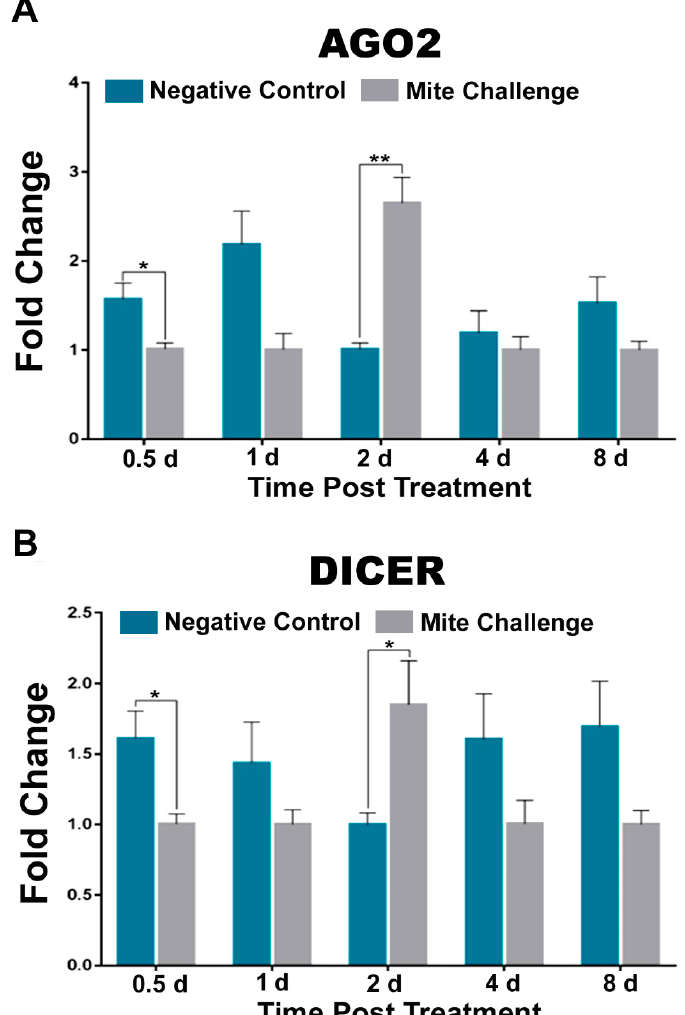
Figure 3. Fold change of the transcription profiles for components of RNAi pathway between the negative control (without Varroa challenge) and bees challenged with Varroa mites at different time points post treatment (days). ( A ) dsRNA binding AGO2 and ( B ) ribonuclease Dicer transcripts demonstrating down-regulation at all timepoints, except for significant upregulation two days post treatment. (* p < 0.05, ** p < 0.01).